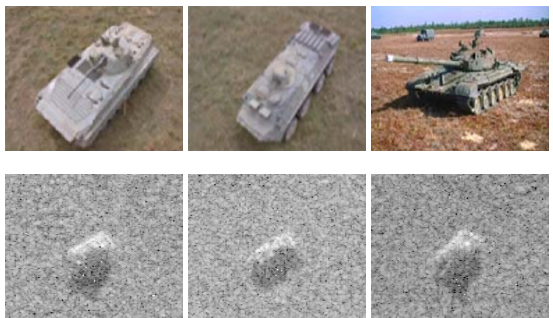
Figure 7. Optical images ( top ) and corresponding synthetic aperture radar (SAR) images ( bottom ). From left to right: BMP2, BTR70,